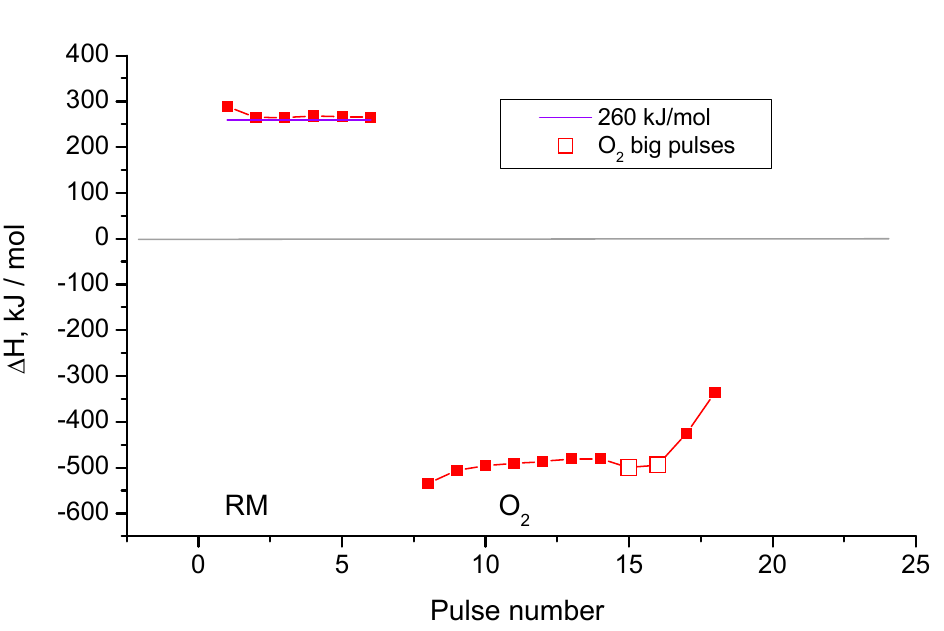
Figure 10. Conversions of reagents and product characteristics in series of the reaction mixture pulses followed by O 2 pulses at 773 K.